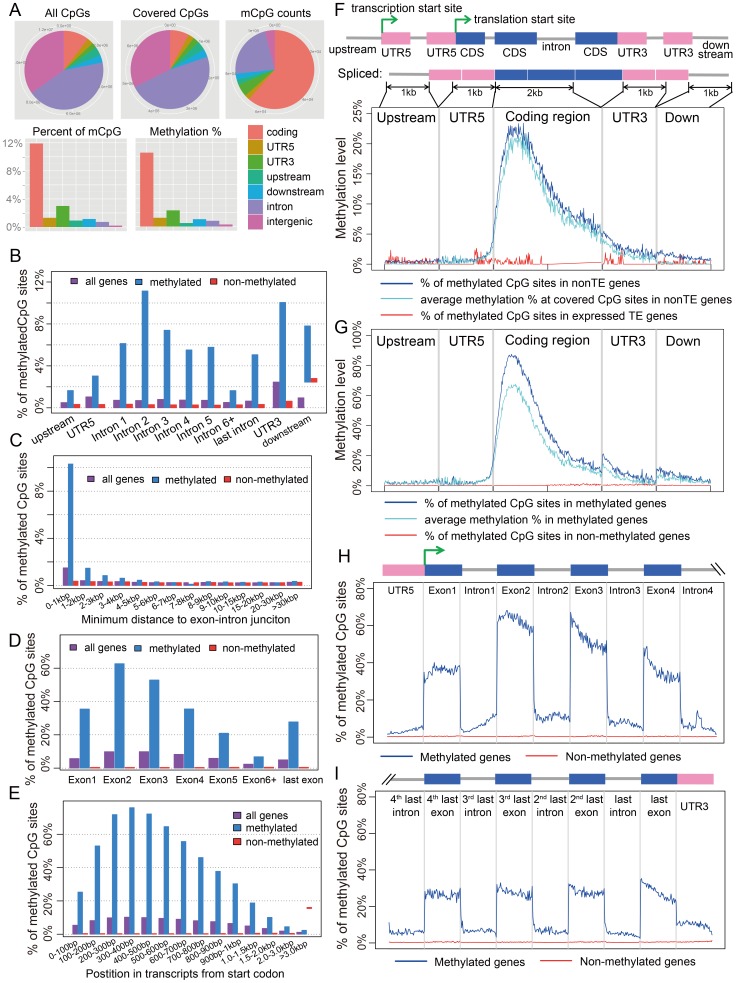
Distribution of CpG DNA methylation in the Nasonia genome across protein-coding genes.(A) Distributions across genomic features for all 14 million CpG sites (Top left), 8 million covered CpG sites (Top middle) and methylated CpG sites (mCpGs, Top right). Plotted in the bottom panel are the distributions for percentage of mCpGs and methylation percentage at covered CpG sites. (B) Percentage of mCpGs in the 1 kbp upstream, 1 kbp downstream, UTR and intronic regions for methylated (blue), non-methylated (red) and all genes (purple). (C) Percentage of mCpGs in introns for methylated (blue), non-methylated (red) and all genes (purple), binned by the nearest distance to the exon-intron junctions. (D) Percentage of mCpGs across exons for methylated (blue), non-methylated (red) and all genes (purple). (E) Percentage of mCpGs in the coding region starting from first codon for methylated (blue), non-methylated (red) and all genes (purple). (F) Methylation level in 1 kbp upstream, 1 kbp 5′-UTR, first 2 kbp coding, 1 kbp 3′-UTR and 1 kbp downstream regions for 1,540 expressed transposable element genes (TE genes) and 16,186 non-TE genes. Dark blue line: percentage of mCpGs for non-TE genes; light blue line: average methylation percentage across covered CpGs for non-TE genes; red line: percentage of mCpGs for TE genes. (G) Methylation level in 1 kbp upstream, 1 kbp 5′-UTR, first 2 kbp coding, 1 kbp 3′-UTR and 1 kbp downstream regions for 4,751 methylated non-TE genes and 12,975 non-methylated non-TE genes. Dark blue line: percentage of mCpGs for methylated genes; light blue line: average methylation percentage across covered CpGs for methylated genes; red line: percentage of mCpGs for non-methylated genes. (H–I) Plot of Percentage of methylated CpG sites in the 5′UTR, the first four exons and introns (H) and 3′UTR, the last four exons and introns (I) for methylated (blue) and non-methylated genes (red). All exons, introns and UTRs were rescaled to the same length.